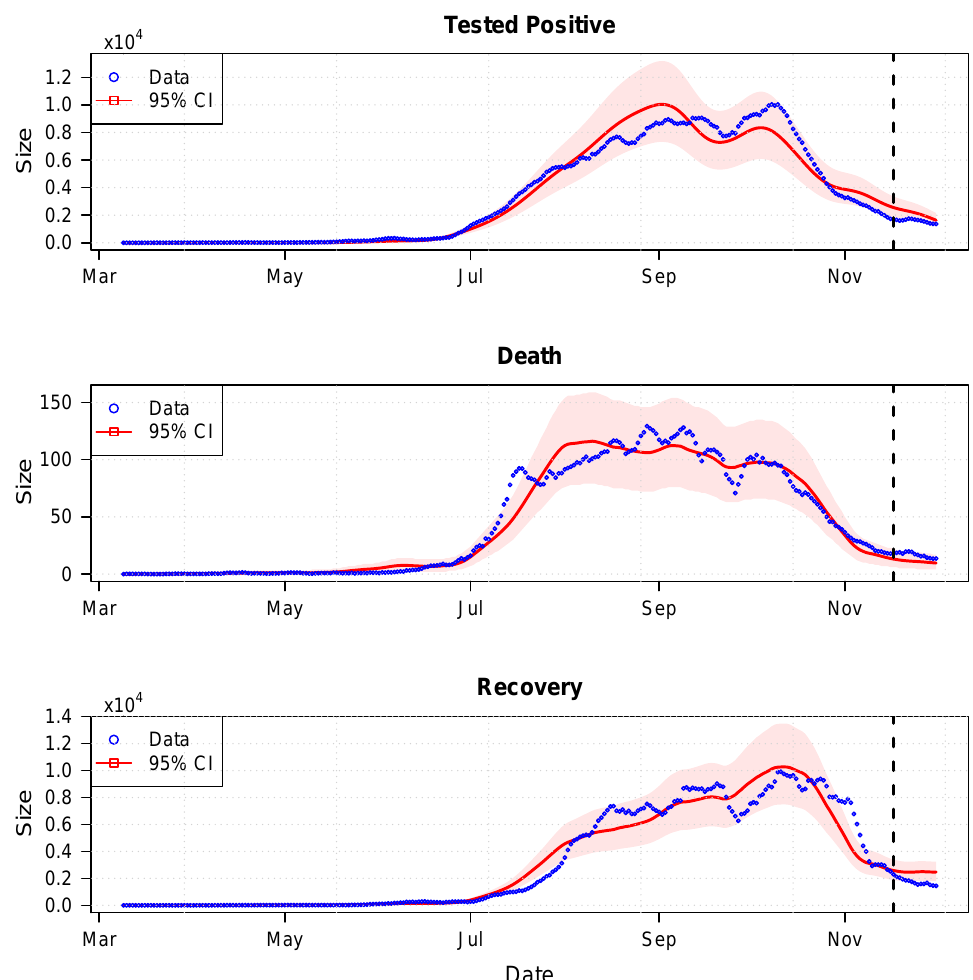
Figure 2. The posterior mean and 95% credible bands for reported tested positive cases, death, and recovery cases of state Karnataka. The blue circles represent the observed data, the red lines represent the posterior mean and the red bands represent the 95% credible interval. The vertical dashed black lines divide the training and validation